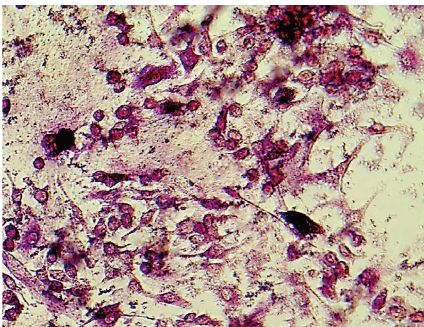
Figure 3: Red TRAP-stained bone marrow-derived cells were imaged with the Plus 2.0 software (Motic Images Plus 2.0, Canada) and an inverted microscope (Motic AE 2000, USA). Tree sites were randomly selected and evaluated in each well of a 24-well plate. Positive TRAP staining was quantifed as > 3 nuclei per cell (220 ± 32.56) using the ImageJ software (ImageJ/Fiji 1.53a, NIH,